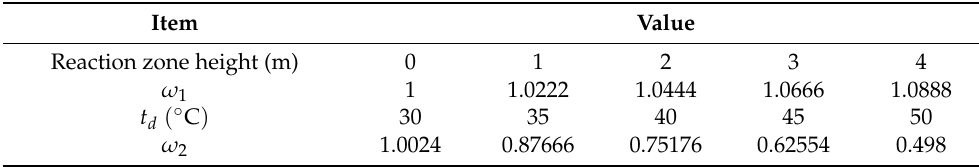
Table 2. The ratio of convective heat transfer to total heat transfer. Item Value Reaction zone height